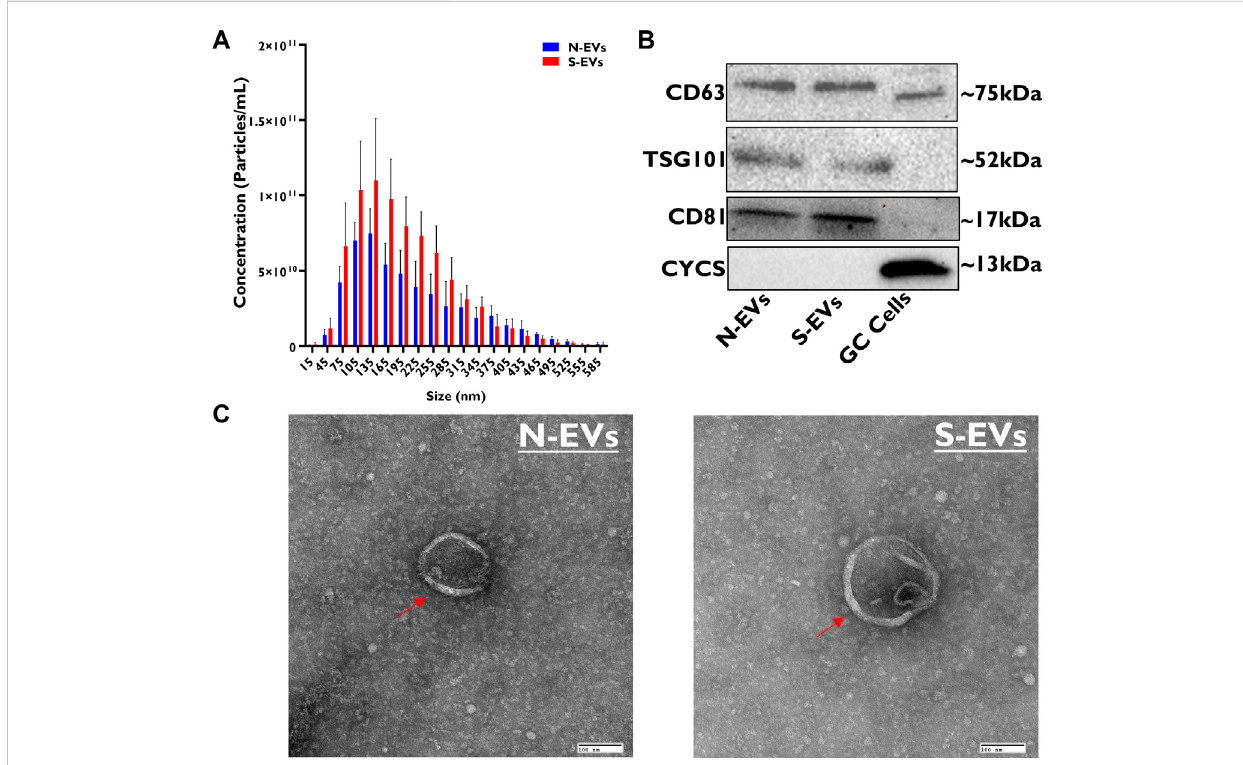
FIGURE 1 Morphological and molecular characterization of GC-EVs. The relative size of EVs isolated from cultured granulosa cells spent culture medium was determined using nanoparticle tracking analysis (NTA). The median size of N-EVs was 137.75 nm (blue) compared to S-EVs 147.95 nm (red). Granulosa cells subjected to thermal stress released a signi fi cantly higher quantity of particles (red) and had tendencies to be larger in size (nm) compared to those subjected to normal ambient temperatures (blue) (A) . Immunoblotting analysis for EV-speci fi c protein markers (CD63, TSG101, and CD81) and cellular-speci fi c protein marker (CYCS) were veri fi ed to determine protein lysate composition in N-EVs, S-EVs, and GCs as a positive control. Full-length blots are presented in Supplementary Figure S1 (B) . Transmission electron microscopy (TEM) representative images from N-EVs and S-EVs (marked with red arrows) show the morphology of the lipid bilayer membrane of EV particles. Scale bar, 100 nm (C)